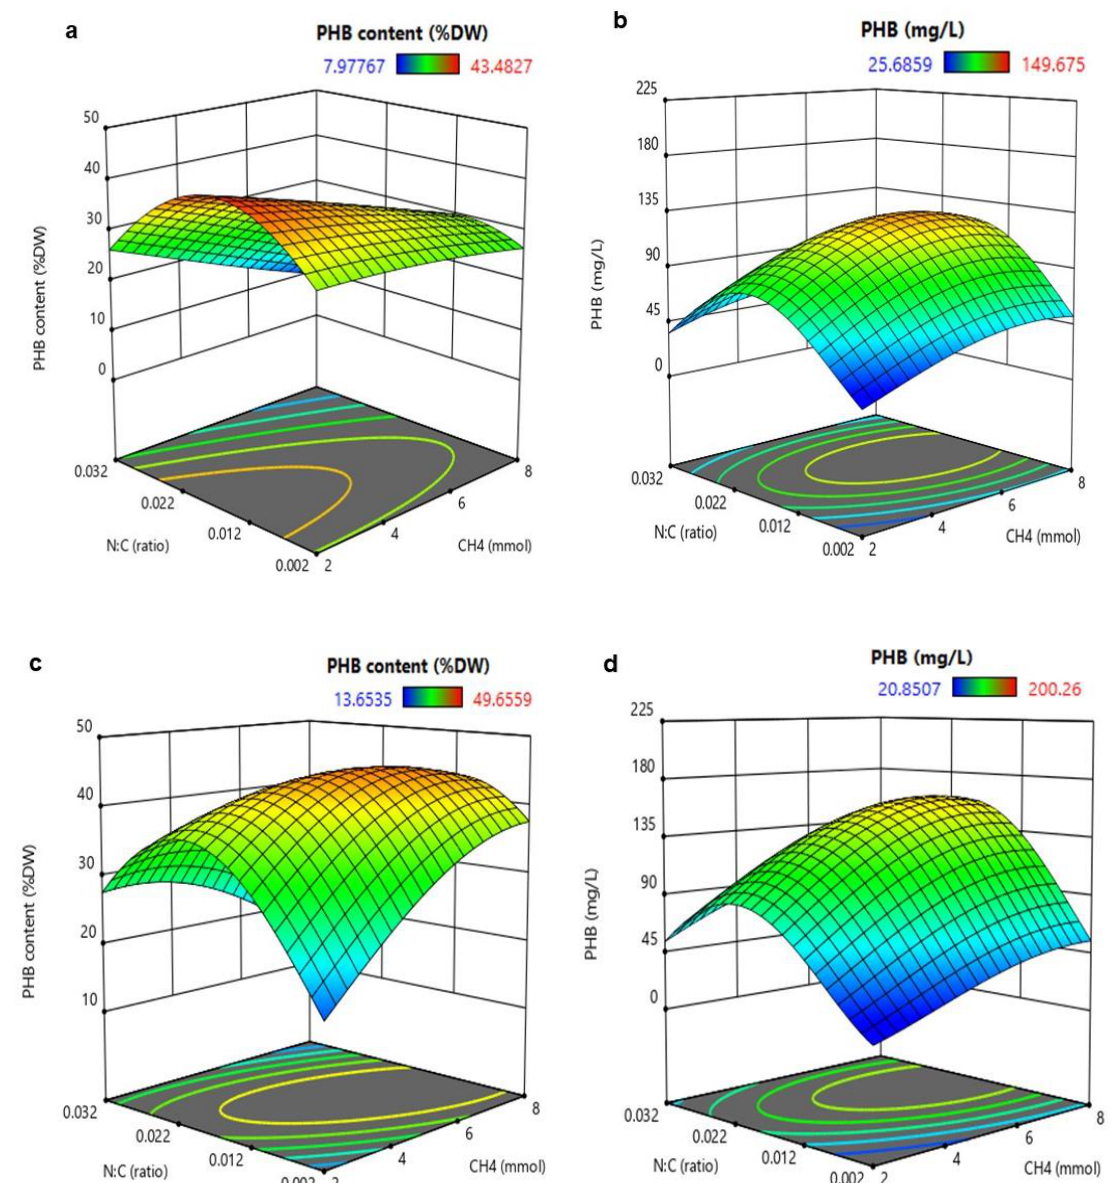
Figure 2. RSM results for PHB production (PHB% cell content as % dry weight and PHB amount in mg/L) in stationary phase batch cultures of Methylocystis sp. Rockwell grown with varying amounts of methane against varying N:C ratios. Results are shown for cells grown in NMS ( a , b ) and AMS ( c , d ) media ( n = 3).